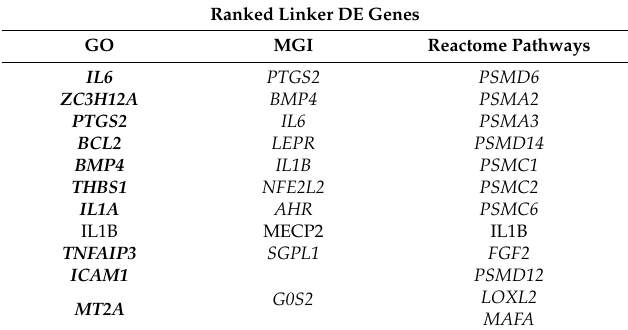
Table 8. Top ranked linker DE genes resulting from rank aggregation of each linker gene list vocabulary.